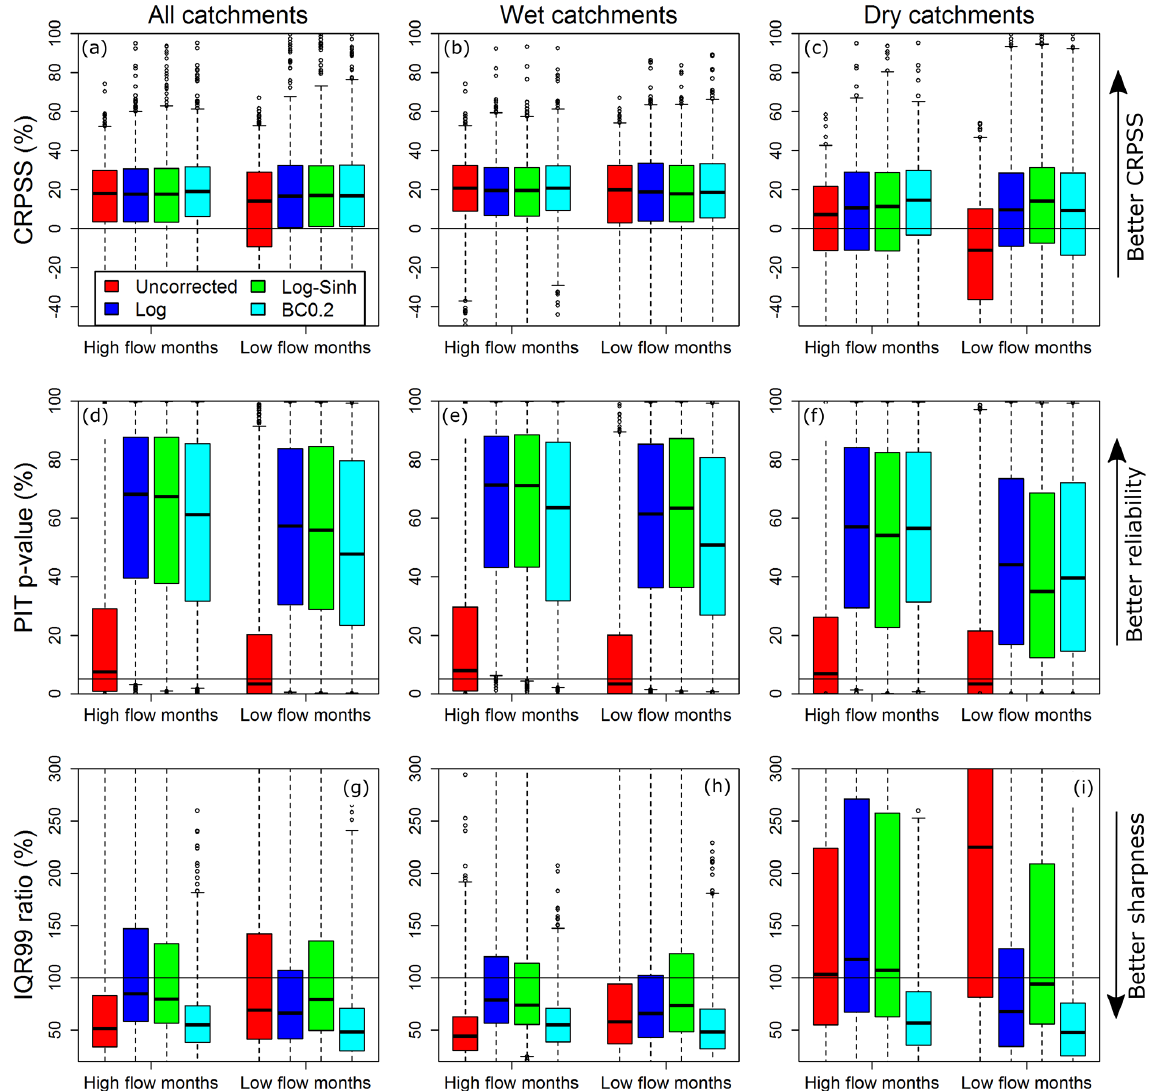
Figure 4. Performance of monthly forecasts in terms of CRPSS, reliability (PIT p -value), and sharpness (IQR99